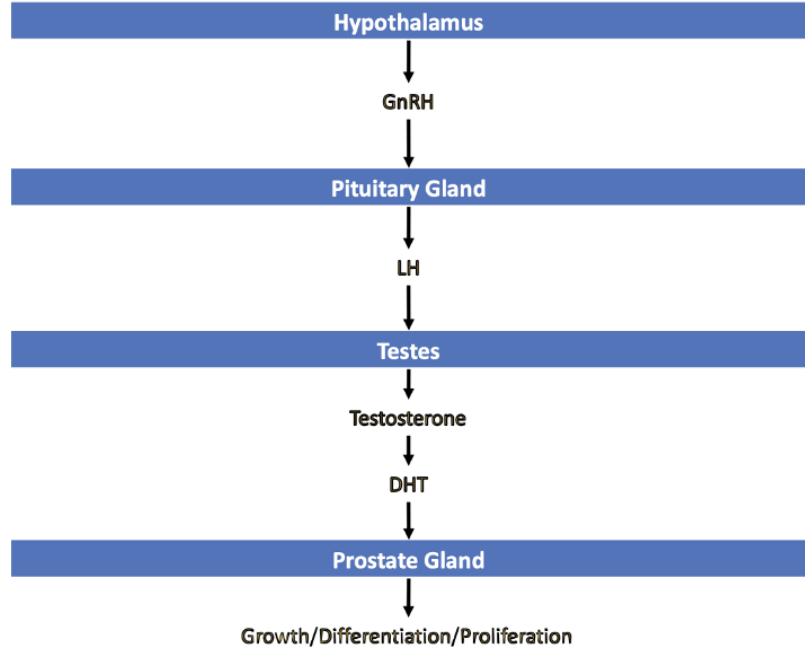
Figure 2. The hypothalamic–pituitary–gonadal axis control of the prostate.